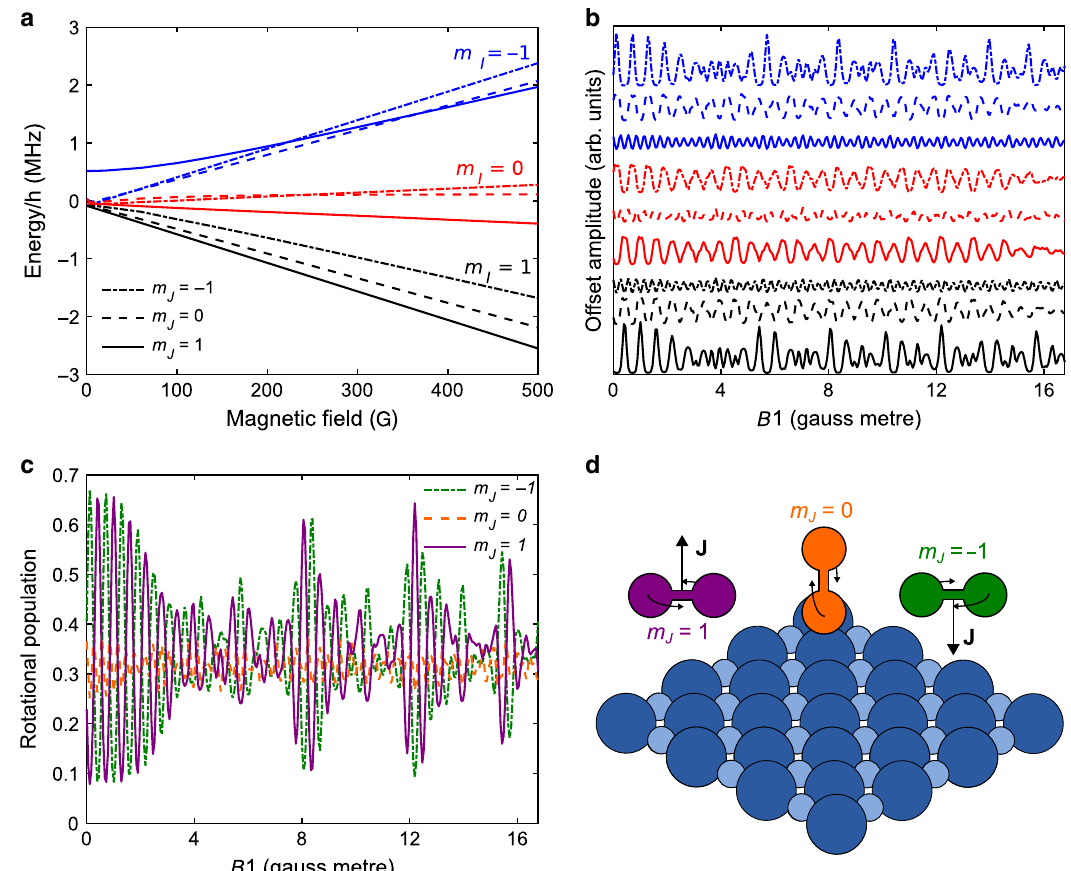
Fig. 2 The effect of magnetic fi elds on ortho-hydrogen. a The magnetic fi eld dependence of the energy of the m I , m J states of ortho-H 2 in J = 1 calculated using the Ramsey Hamiltonian 25 . b Calculated populations of the nine different states which reach the surface as a function of the applied magnetic fi eld integral in the fi rst electromagnet, B 1. The projections are de fi ned using the surface normal as the quantisation axis with each line being de fi ned in the same way as in panel a, and the lines are shifted with respect to each other for clarity. c Calculated populations of the three different m J states (summing over m I states) which reach the surface as a function of the applied magnetic fi eld integral in the fi rst electromagnet, B 1. The projections are de fi ned using the surface normal as the quantisation axis. d Schematic classical depiction of the m J = 1 and m J = − 1 ‘ helicopter ’ states and the m = 0 ‘ cartwheel ’ J